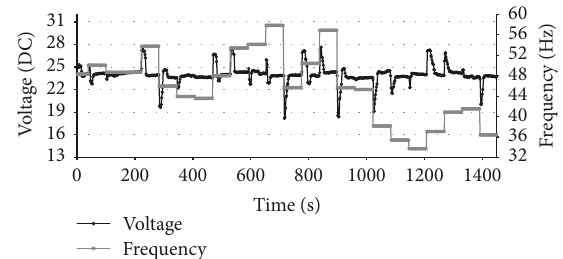
Figure 15: Hydraulic wind power drive train with enabled con- troller.